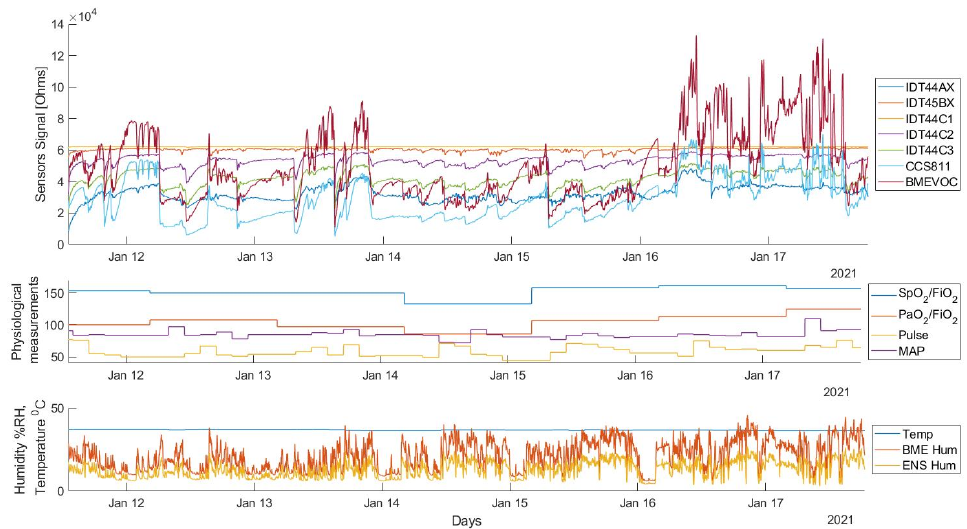
Figure 5. Sensor signals obtained during the ventilation of a patient (total recording time or full registration period). The measurements refer to one-week period.